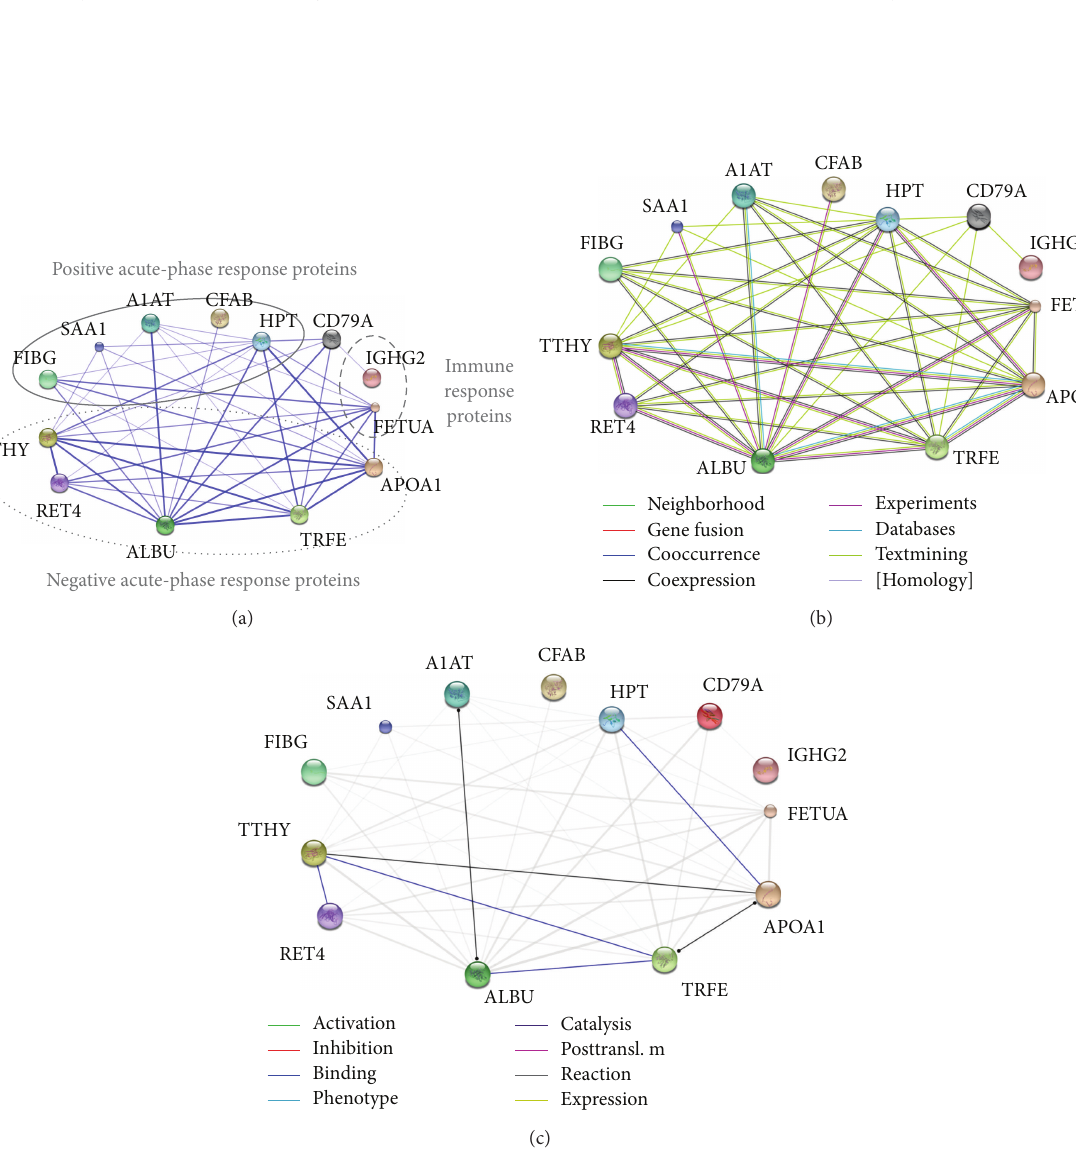
Figure 5: Predicted protein-protein interaction networks (PPI) created by STRING 9.05. Each circle represents an individual protein with the recognized abbreviated name. (a) Confidence PPI in which the thickness of the lines shows how strong the interactions are (threshold: 0.4, medium confidence). Positive, negative APR proteins and immune response proteins are highlighted in three different ellipsis. CD79A is represented with grey colour to indicate an unidentified protein by MS but helpful for linking IGHG2 with HPT. (b) Evidence PPI in which the colour of the lines represent the types of evidence which characterized the protein-protein association. Code lines: green: neighborhood, brown: coexpression, pink: experiments, sky-blue: databases, olive green: textmining. (c) Actions PPI of all proteins in which the different colour of the lines represent the mode of protein actions. Code lines: black: reaction, blue: